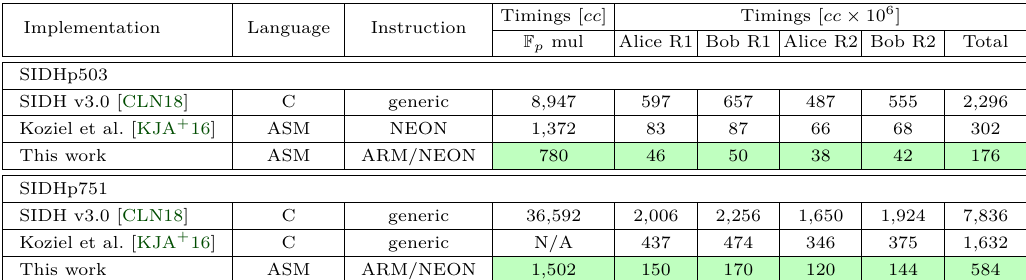
Table 5: Comparison of implementations of the SIDHp503 and SIDHp751 protocols on ARM Cortex-A15 (ARMv7-A architecture). Timings are reported in terms of clock cycles.